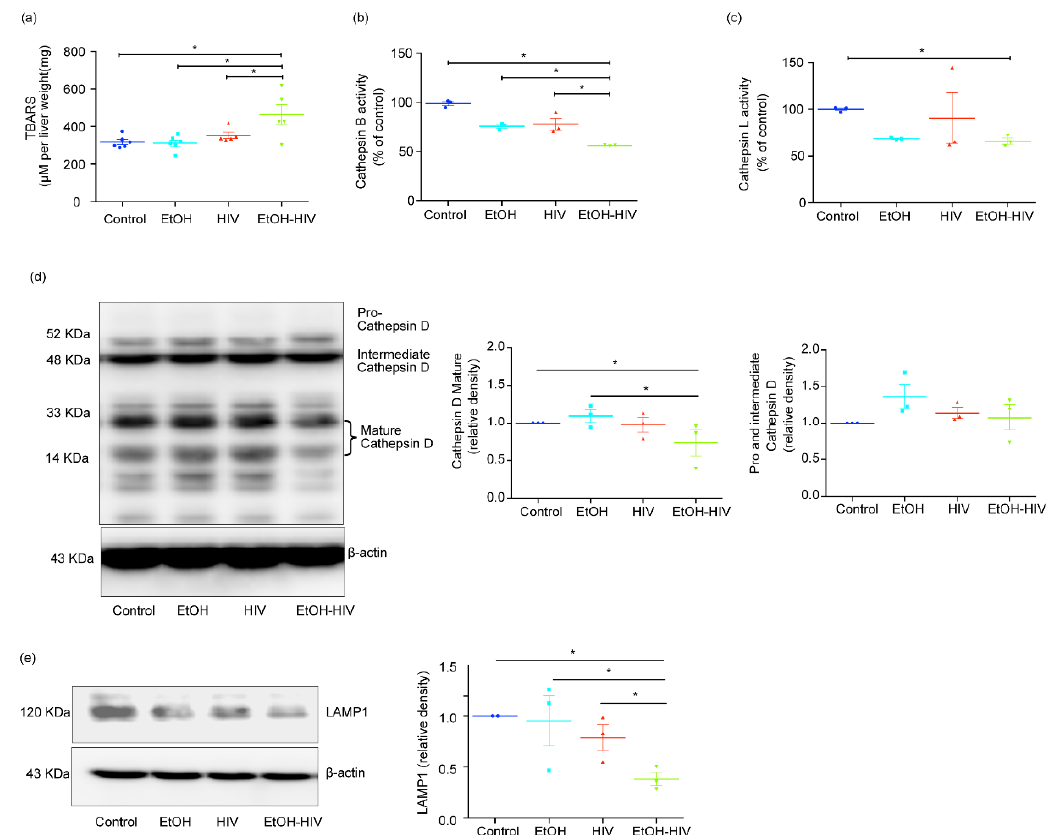
Figure 5. EtOH feeding causes oxidative stress and inhibits the activity of cathepsin B/L and the expression of cathepsin D in the liver of HIV-exposed liver-humanized mice. ( a ) Thiobarbituric acid reactive substances (TBARS) assay. ( b , c ) Cathepsin B ( b ) and cathepsin L ( c ) activities significantly suppressed by EtOH feeding in the liver of HIV-infected humanized mice. ( d ) Representative Western blot and densitometric analysis of mature cathepsin D (33 and 14 KDa) and pro–and intermediate cathepsin D (52 and 48 KDa, respectively). ( e ) Representative Western blot and densitometric analysis of LAMP1. ( d , e ) β -actin was used as a loading control. Statistical significance between treatment groups is indicated by asterisk and determined by two tailed Student’s t -test (* p ≤ 0.05).